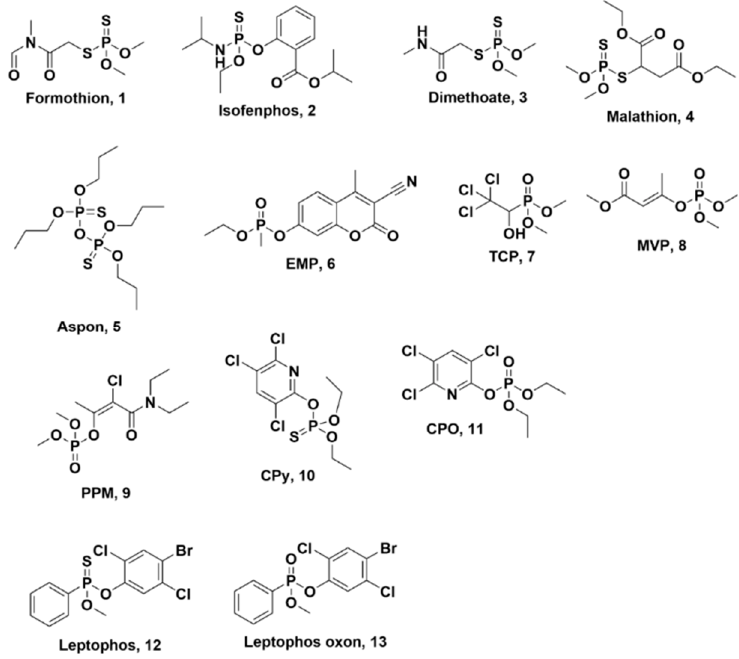
Figure 2. Structures of select OPs used in HLM metabolism study.